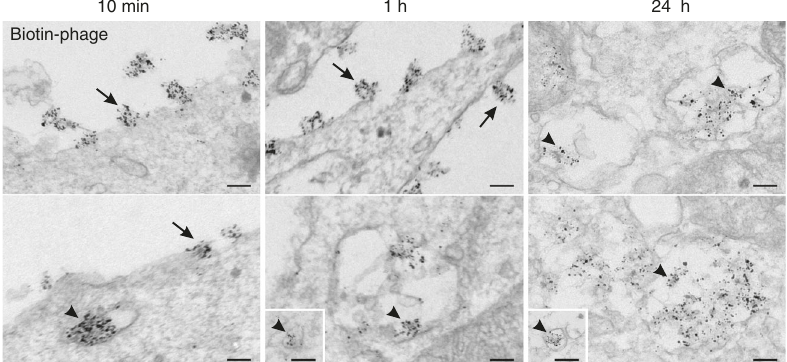
Fig. 8 Ultrastructural visualization of internalized phages. Transmission electron micrographs of thin sections of kSK-N-SH cells incubated with biotin- conjugated PK1A2 phages at 37 °C for the times indicated. After incubation, the cells were fi xed and stained with Alexa Fluor 488 FluoroNanogold- streptavidin probe, followed by silver-enhanced nanogold and gold toning treatments. Phage particles decorated with enhanced gold particles are seen at the cell surface (arrows) and within cytoplasmic vesicles (arrowheads). The scale bars represent 100